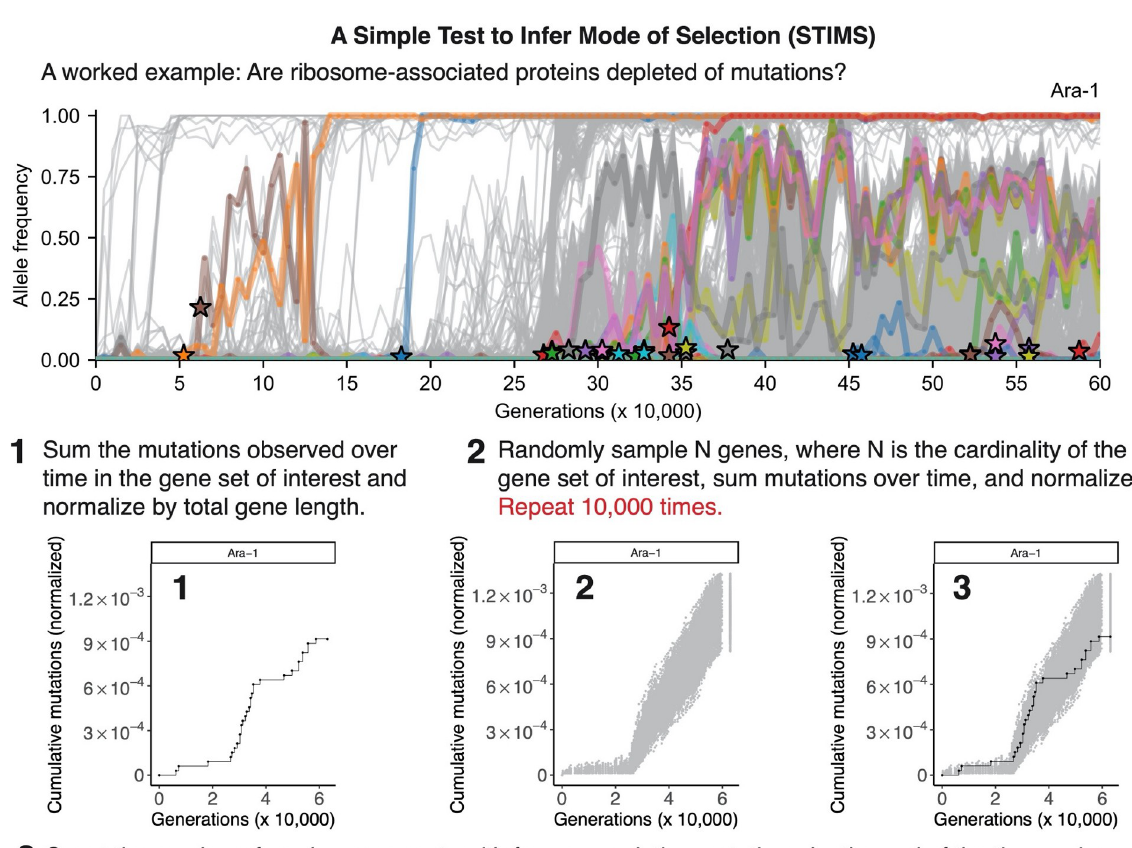
Fig 2. The STIMS algorithm. When examining the evolutionary dynamics of a gene set of interest, one often wants to know whether the set is enriched or depleted of observed mutations over time. To test for depletion, we use the non-parametric bootstrap to estimate the fraction of randomized gene sets that have fewer mutations over time than the query gene set. For example, if 11% of randomized gene sets have fewer mutations by end of the time series than the query gene set, then the query gene set is not depleted of mutations (one-tailed p -value = 0.11). A similar derivation holds for tests of enrichment. This worked example uses the allele frequency dynamics of ribosome-associated proteins in the Ara − 1 population of Lenski’s long term evolution experiment with Escherichia coli (LTEE) to illustrate how the STIMS algorithm works. This population evolved a hypermutator phenotype around the 26,250-generation time